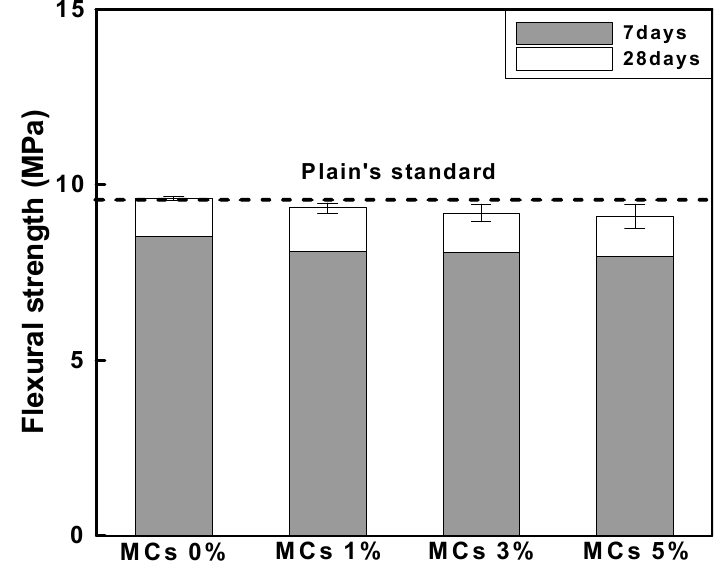
Figure 13. Evaluation result of flexural strength according to MCs.